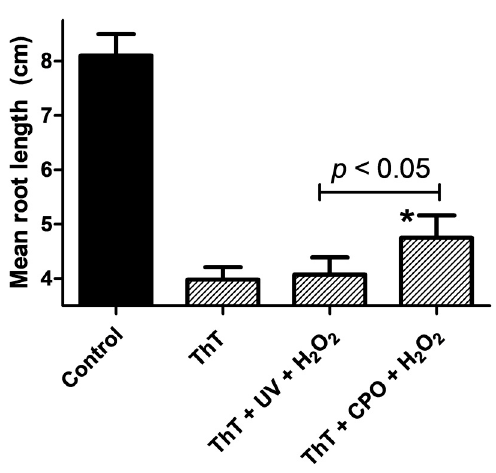
Figure 7. ThT dye toxicity on Lactuca sativa seeds, as measured by the mean root lengths (cm) of seeds after treatment with ThT dye (25 ppm), ThT dye treated by UV + H 2 O 2 , or ThT dye treated by CPO + H 2 O 2 . Statistical analyses were performed using an unpaired t ‐ test ( n = 40); asterisk (*) denotes a significant difference ( p